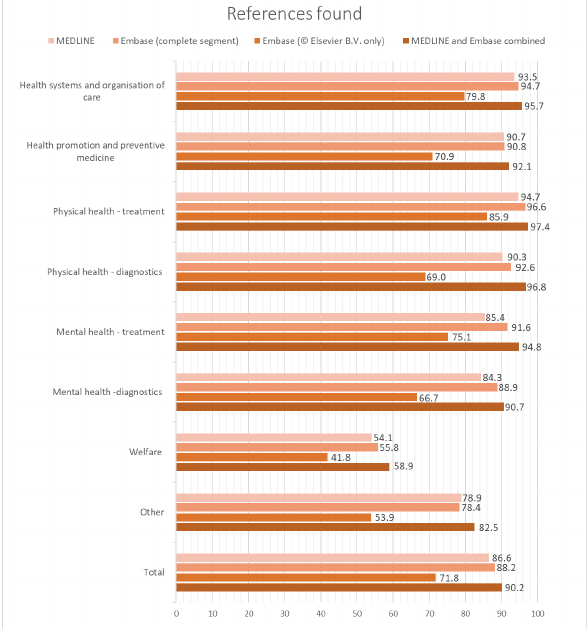
Figure 1 The indexing rate by category and database Table 2 The span in the indexing rate, per